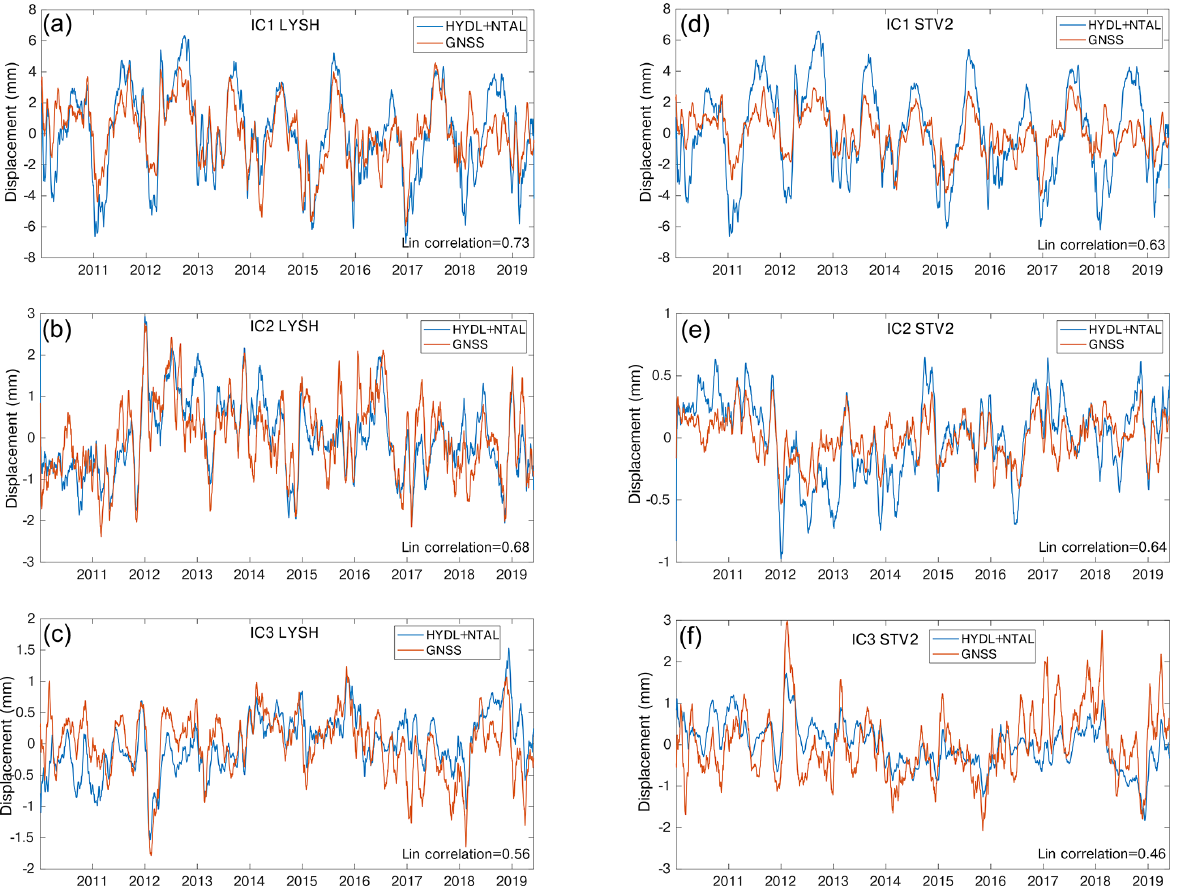
Figure 8. Comparison at the GNSS LYSH site (lat: 49.55 ◦ ; long: 18.45 ◦ ) between the displacements associated with (a) GNSS_IC1 and NTAL + HYDL_IC1, (b) GNSS_IC2 and NTAL + HYDL_IC2, and (c) GNSS_IC3 and NTAL + HYDL_IC3. Panels (d) , (e) and (f) are the same as (a) , (b) and (c) , respectively, for the STV2 (lat: 44.57 ◦ ; long: 6.11 ◦ ) site. A 30d moving average filter is applied to better visualize the data.